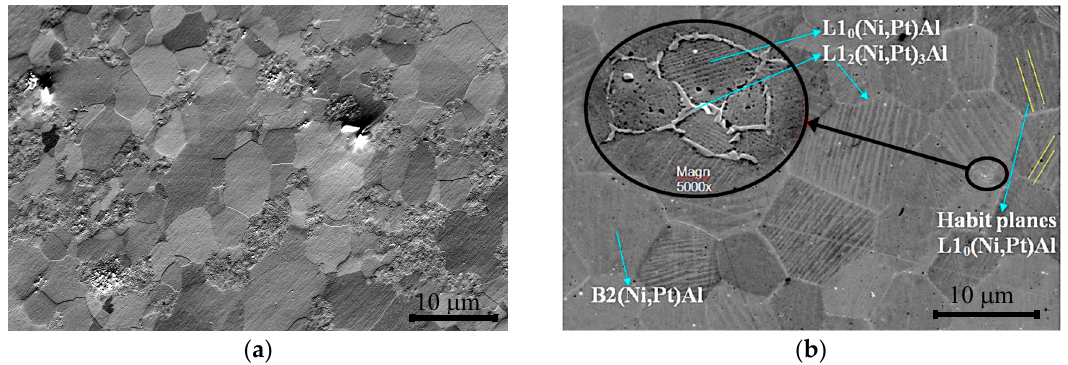
Figure 3. SEM micrographs of the bond coat surface ( a ) before and ( b ) after scale free oxidation for 110 min. B2 ‐ (Ni,Pt)Al, L1 0 ‐ (Ni,Pt)Al and L1 2 ‐ (Ni,Pt) 3 Al phases are identified with arrows. The martensite phase is well identified in ( b ) by its habit planes.